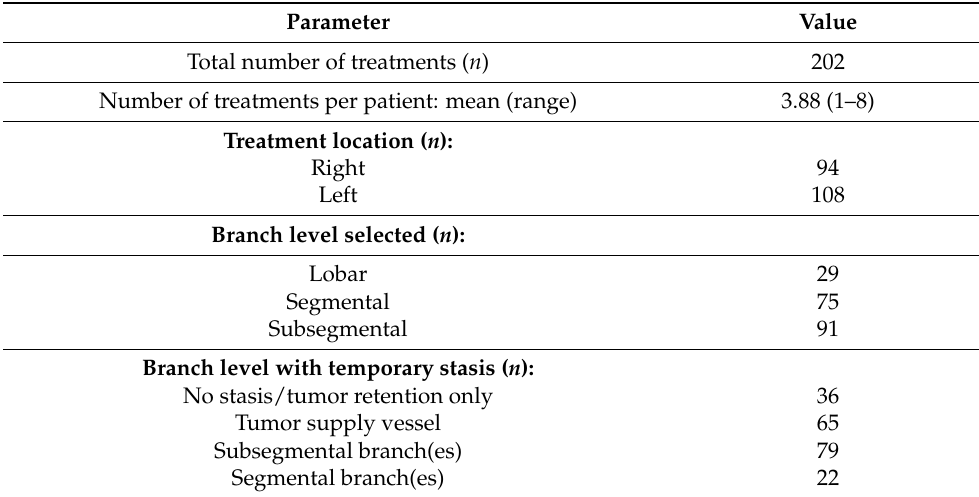
Table 2. Technical details of therapy with drug-eluting microspheres (100 µ m) loaded with irinotecan. Parameter